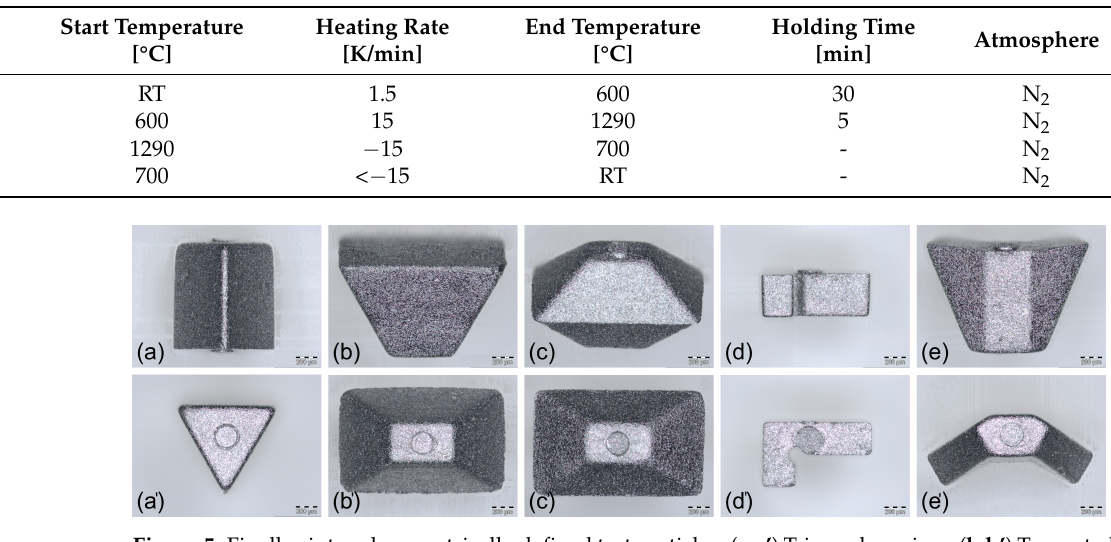
Table 2. Parameters applied for the combined thermal debinding and sintering procedure.